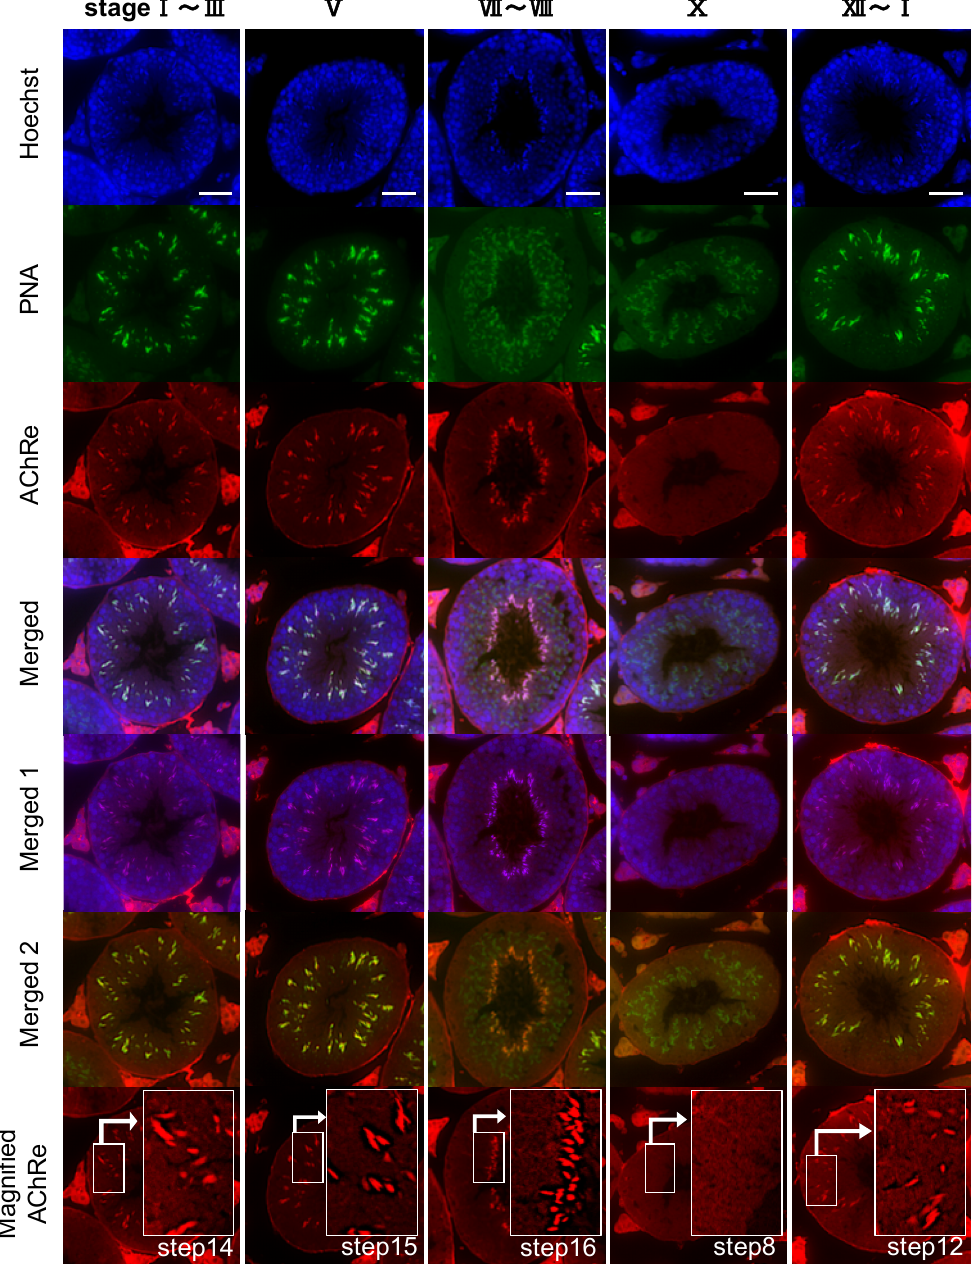
Figure 3. Testis AChRe localization analysis by immunocytochemistry. (Merged 1): Merged image of nuclear and AChRe. (Merged 2): Merged image of acrosome and AChRe. Note the immunoreactivity detected in spermatids from step 12 onwards. AChRe was expressed in spermatids from the end of spermatogenesis process to just before ejaculation. Blue, nuclear (Hoechst 33342); green, acrosome (FITC-PNA); red, AChRe; bars = 50 µm.